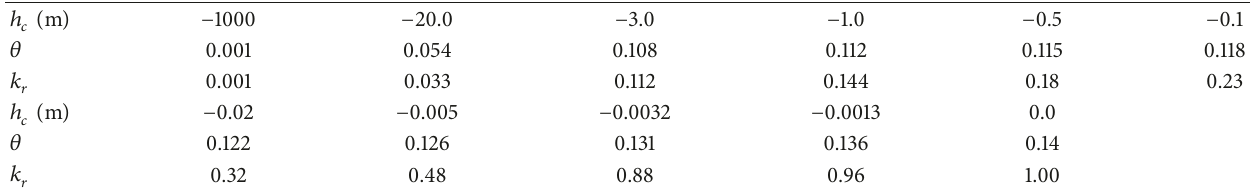
Table 1: Seepage parameters of rocks.